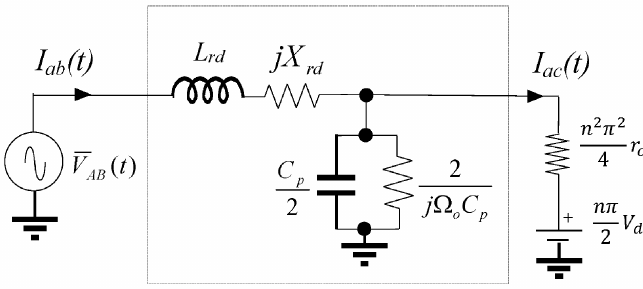
Figure 6. Large-signal reduced-order envelope model of the inverter stage.